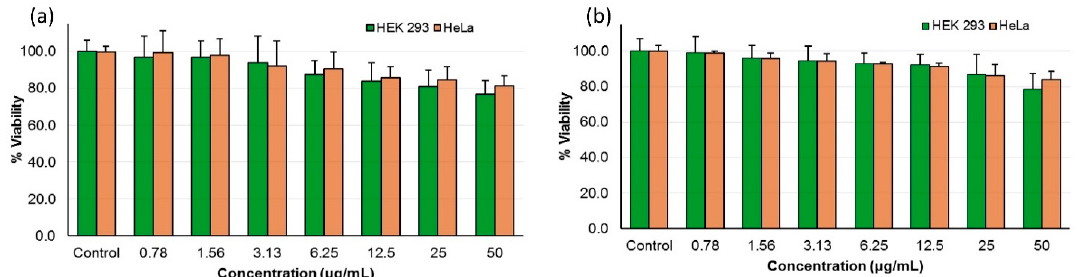
Figure 3. Mammalian cell cytotoxicity of peptide ( a ) 10d and ( b ) 10o as percentage viability of HEK-293 and HeLa cells at different concentrations. Table 4. Cytotoxicity and hemolytic activities of the active peptides .